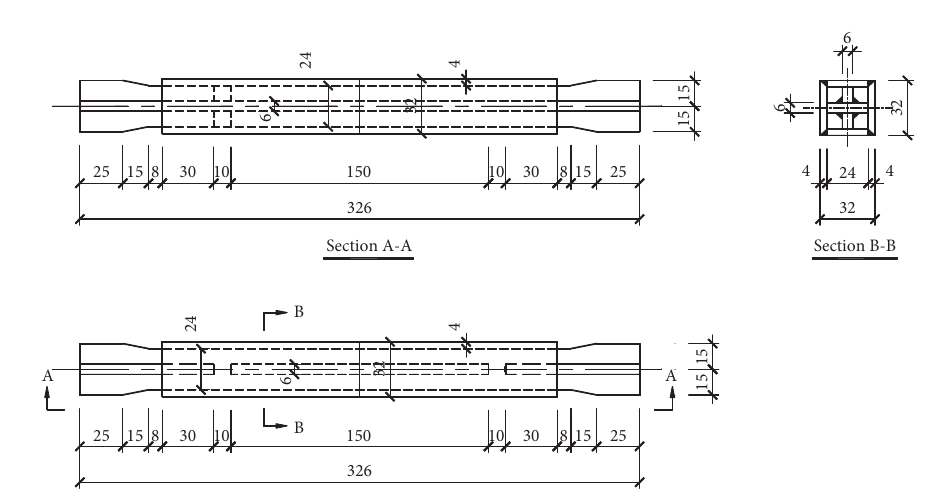
Figure 7: Details of the